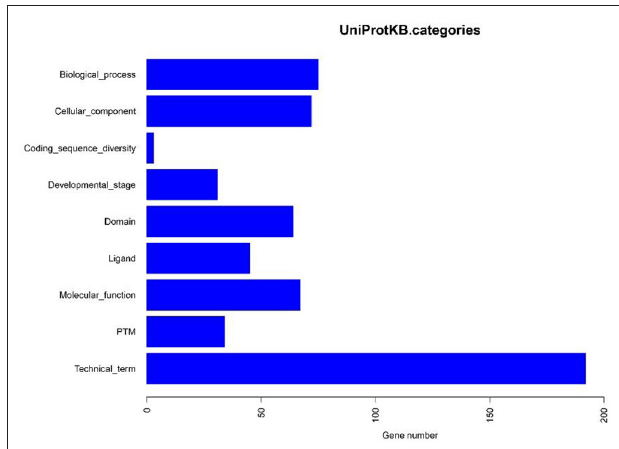
FIGURE 7 | UniProtKB category statistics.